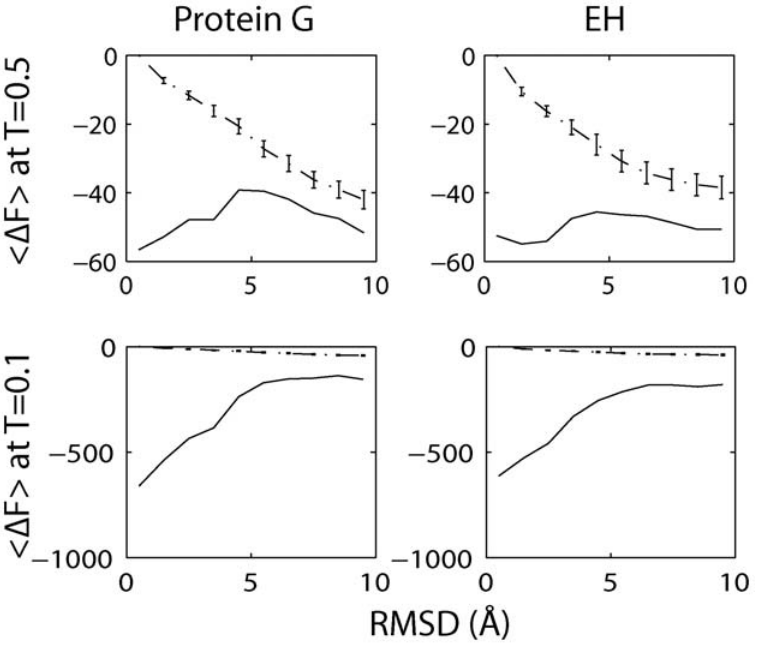
Figure 3. Average free energies ( , D F . ) as a function of C a RMSD for temperatures of 0.5 and 0.1 for protein G and engrailed homeodomain (EH). The black lines are the hypothesized free energy at the given temperature and the dash-dot lines are the free energy at temperature 0.8 shown for reference.